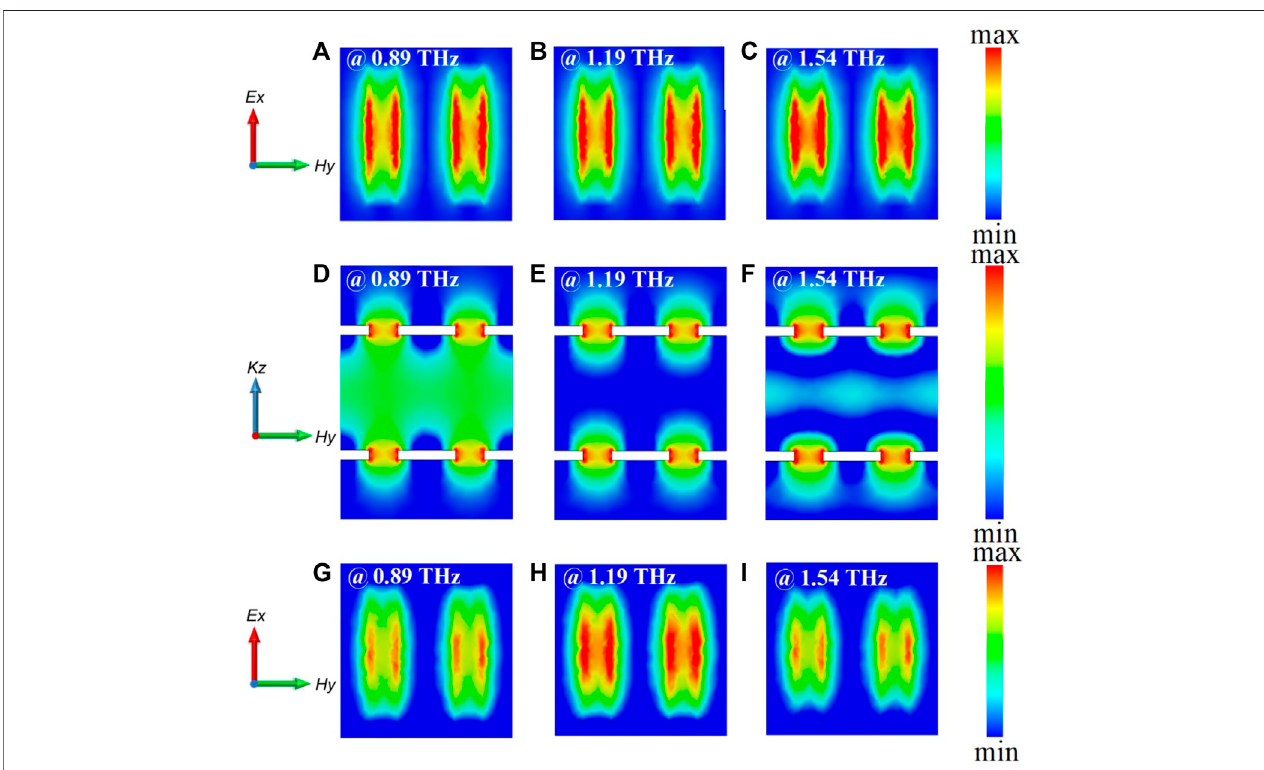
FIGURE3| Electric fi elddistributionsoftheuppermetalsurfaceattransmissionpeaks (A) 0.89THz, (B) 1.19 THz,and (C) 1.54 THz,respectively.Theelectric fi eld distributions on the side of the double-layer structure at transmission peaks (D) 0.89 THz, (E) 1.19 THz, and (F) 1.54 THz, respectively. The electric fi eld distributions of the single layer at transmission peaks (G) 0.89 THz, (H) 1.19 THz, and (I) 1.54 THz,